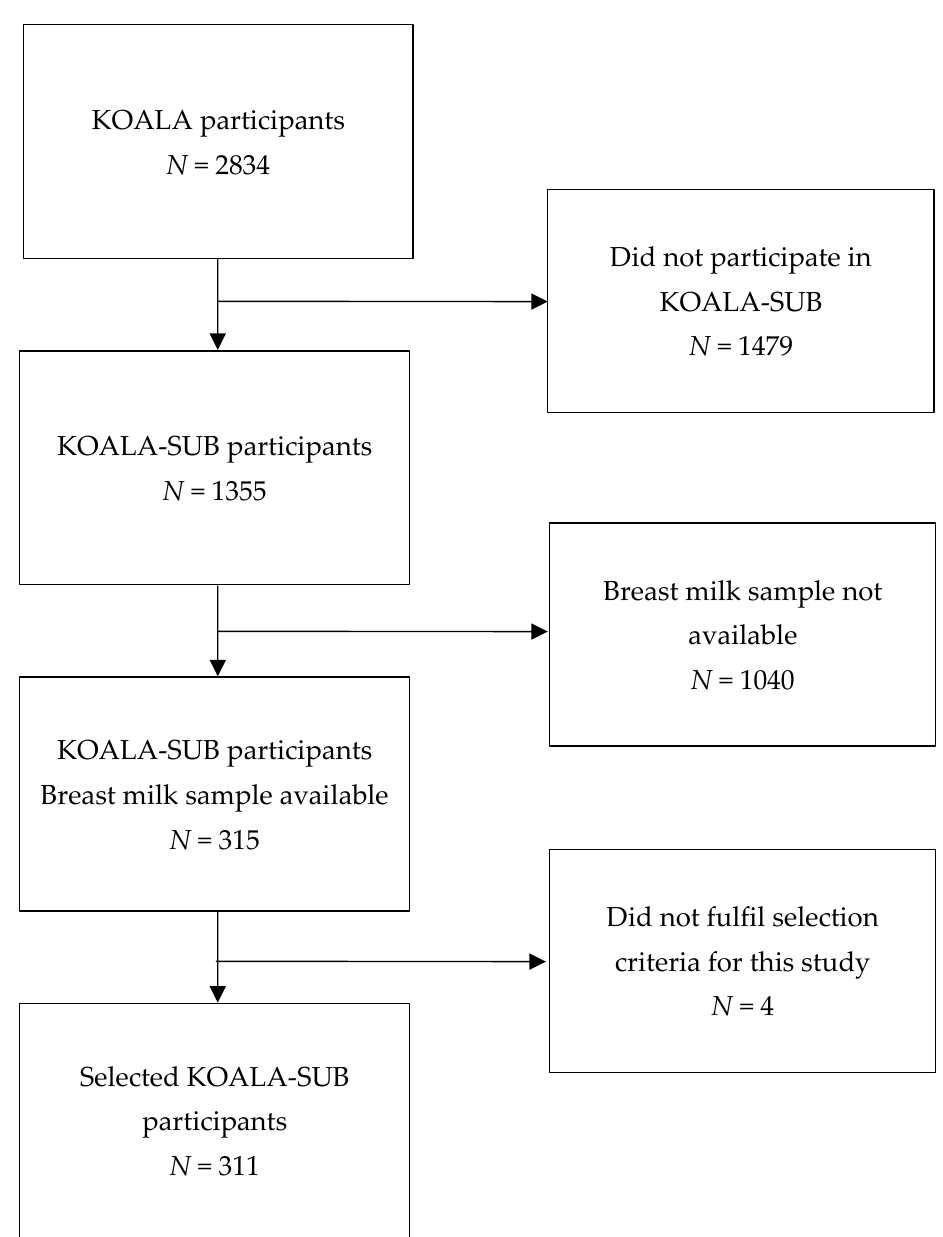
Figure 1. Flow chart of participants included in this study. KOALA = “Kind, Ouders en gezondheid: Aandacht voor Leefstijl en Aanleg”; KOALA -SUB = subcohort of the KOALA study.